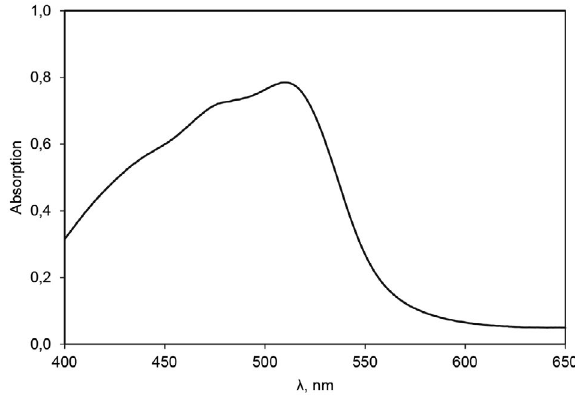
Figure 2. The Ferroin complex absorption spectrum.